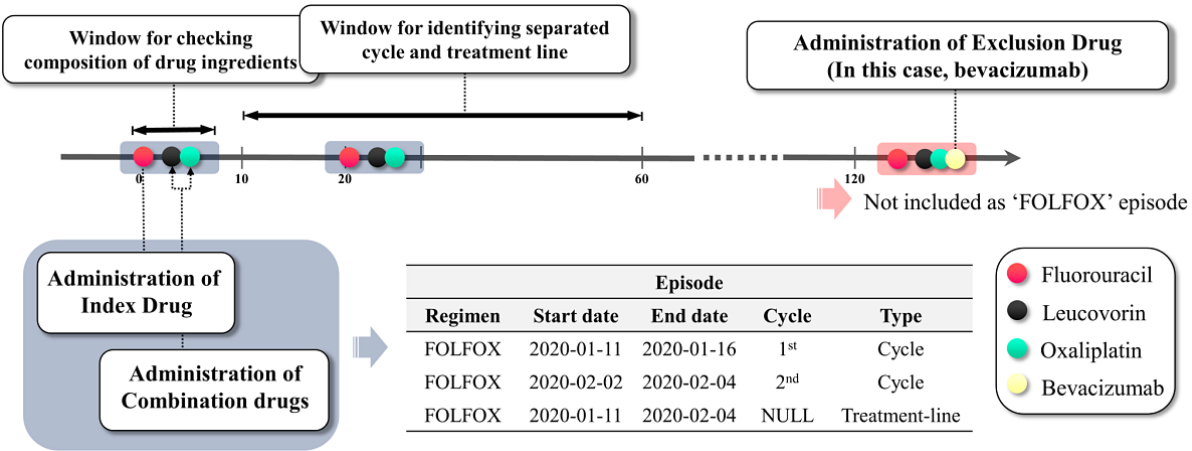
Figure 2. Schematic depiction of algorithm rules in a tool for regimen-level abstraction of chemotherapy episode records. FOLFOX: fluorouracil, leucovorin, and